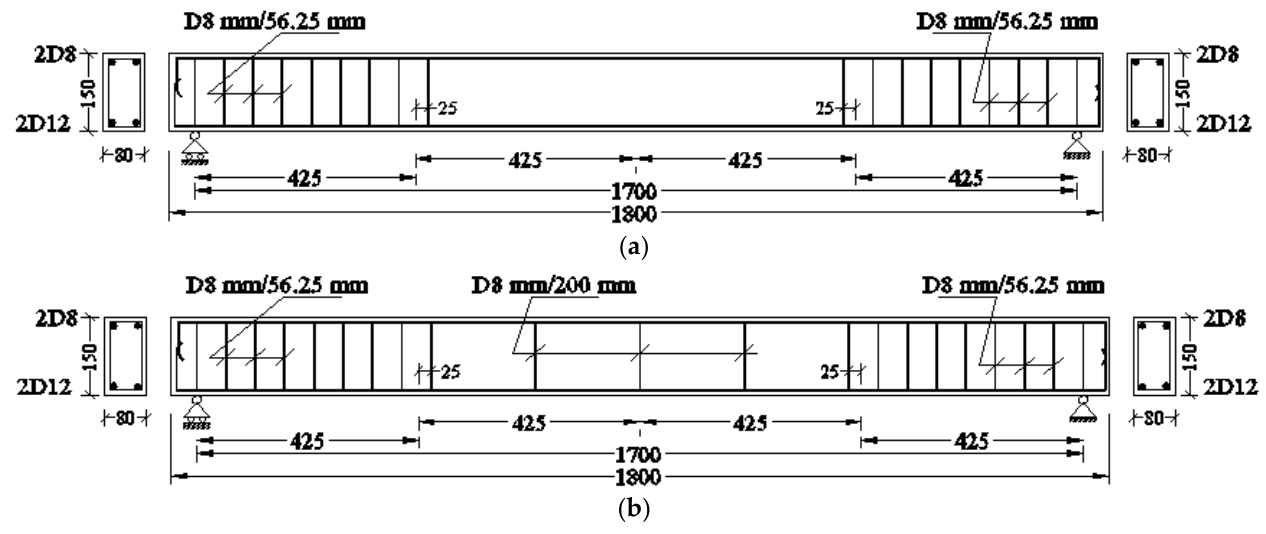
Figure 2. Details of the control specimens: ( a ) control beam B0 and ( b ) control beam B0 *, dim. in mm. The change in depth for the other beams happened in the middle of the span. Six beams (group G1) underwent this alteration from the beam soffit, while the remaining four beams underwent it from the top (group G2). The cross-sectional dimensions of each beam were identical. The depth of each beam had two heights, 150 mm and 250 mm, and the width of each beam was 80 mm. The depth of the right half span was 150 mm, and the depth of the left half span was 250 mm. In other words, the depth of the beams increased by 100 mm in the center of the span. The beams of G1 and G2 are shown in Figures 3 and 4, respectively. The same top secondary compression steel of 2D8 mm and the same bottom longitudinal bars of 2D12 mm were used to reinforce the RC beams for G1 and G2. All beams’ shear spans were 8 mm@56.25